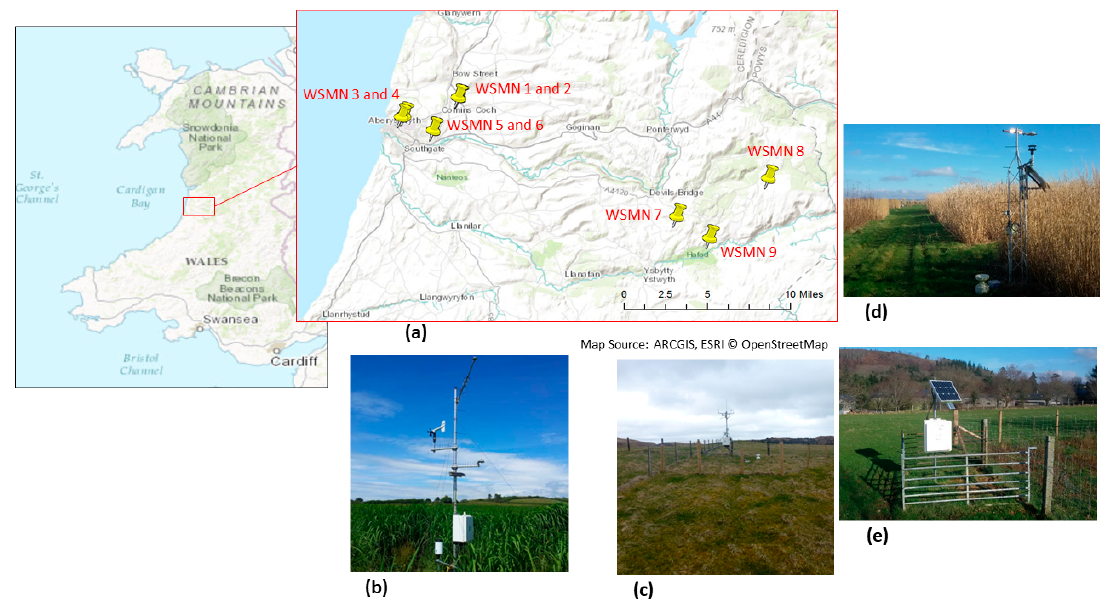
Figure 1. ( a ) Overview of the locations on which the WSMN experimental sites are installed to acquire SM, ST, and ancillary data. Examples of images of the sites from: ( b ) Penglais, ( c ) Pwllpeiran, ( d ) Cae-Canol ( e ) Comins-Coch.